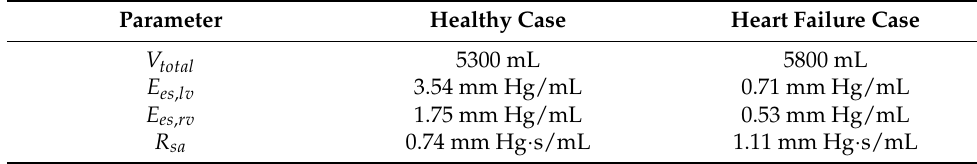
Table 3. Baseline of CVS model.